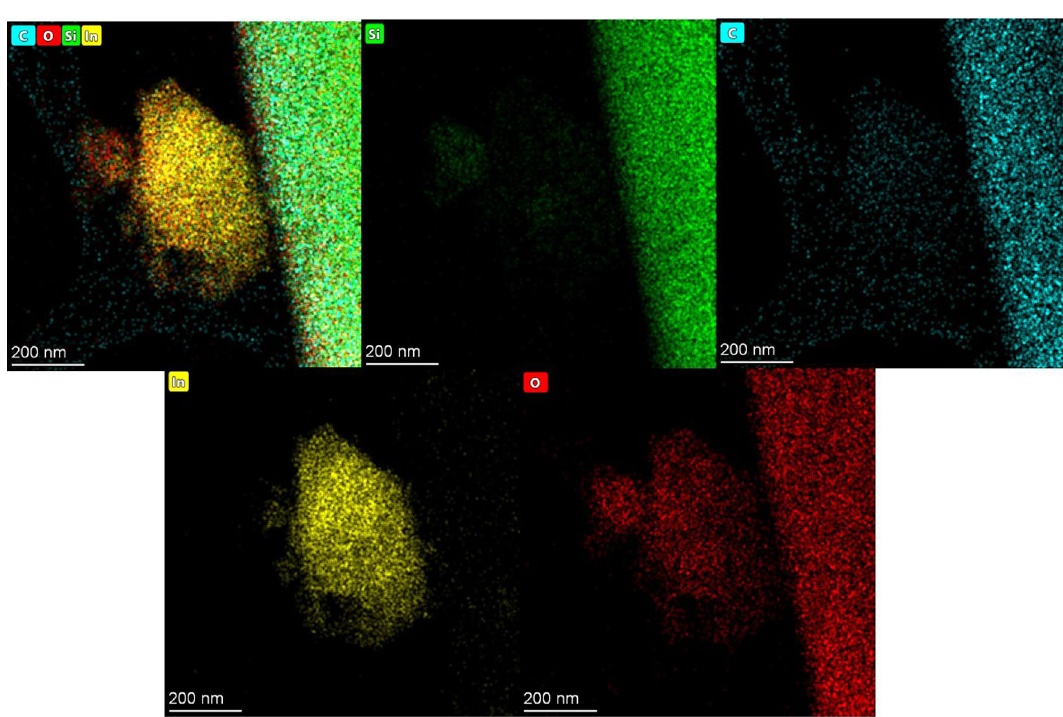
Figure 7. EDS mapping of the SiC-In 2 O 3